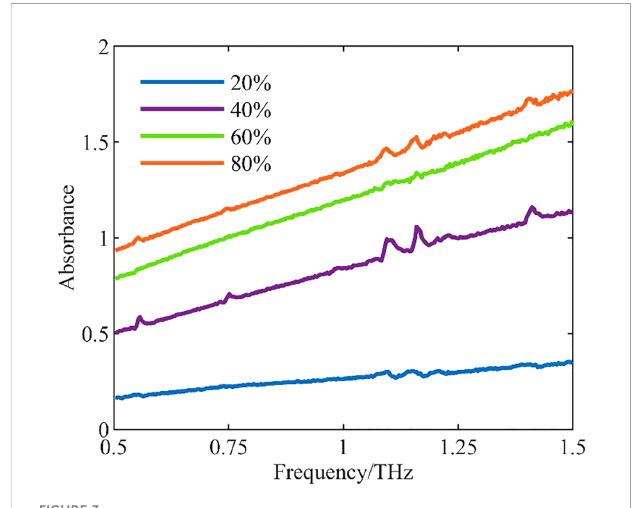
FIGURE 3 Curves of mean absorbance for different leaf water